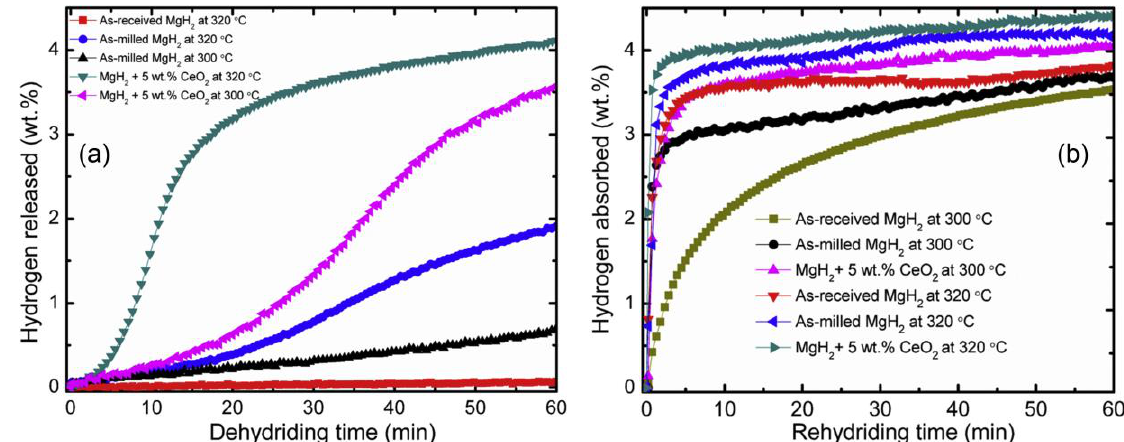
Figure 10. Isothermal dehydrogenation kinetics ( a ) and hydrogenation kinetics ( b ) of the as-milled MgH 2 and MgH 2 doped with 5 wt % CeO 2 at 320 °C and 300 °C. Adapted with permission from [70], Copyright Elsevier, 2017.